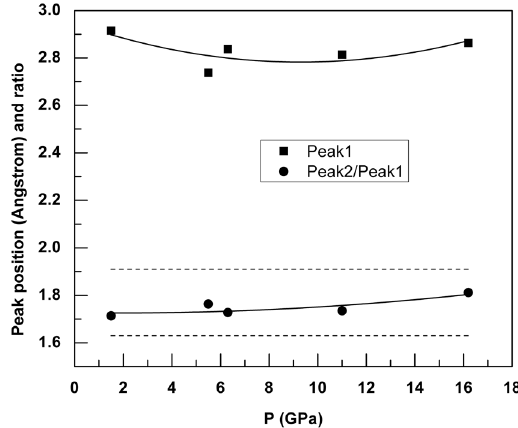
Figure 4. Positions of the first peak in the reduced pair distribution functions, G ( r ), for liquid AuGa 2 ( squares ) and ratio of the second to first peak positions ( circles ). The dashed lines indicate the ideal ratio determined for a simple close-packed hard sphere-like structures ( r 2 / r 1 ≈ 1.91) and for an ideal tetrahedral structural unit ( r 2 / r 1 ≈ 1.63) 8 . The errors in peak positions are in the range of ± 0.002–0.018, smaller than the corresponding symbols.